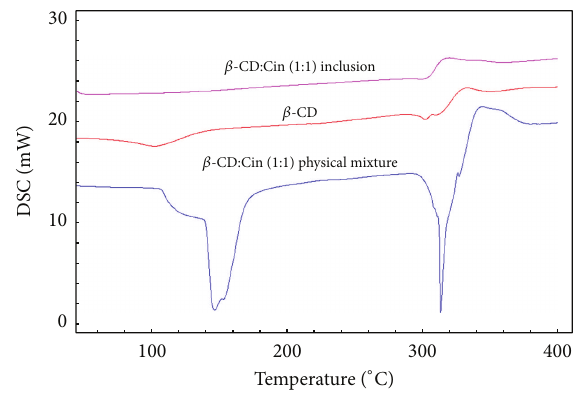
Figure 6: DSC thermograms of a 𝛽 -CD: Cin system. From top: Cin: 𝛽 -CD inclusion complex, pure 𝛽 -CD, and physical mixture of Cin and pure 𝛽 -CD.